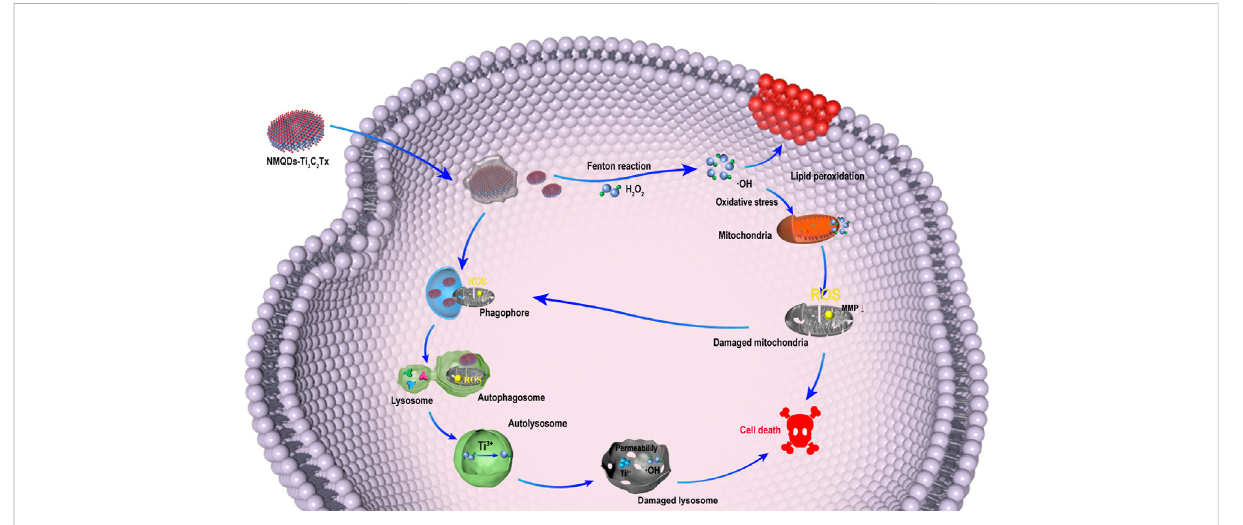
FIGURE 1 Schematic illustrating the antitumor pathway of NMQDs-Ti 3 C 2